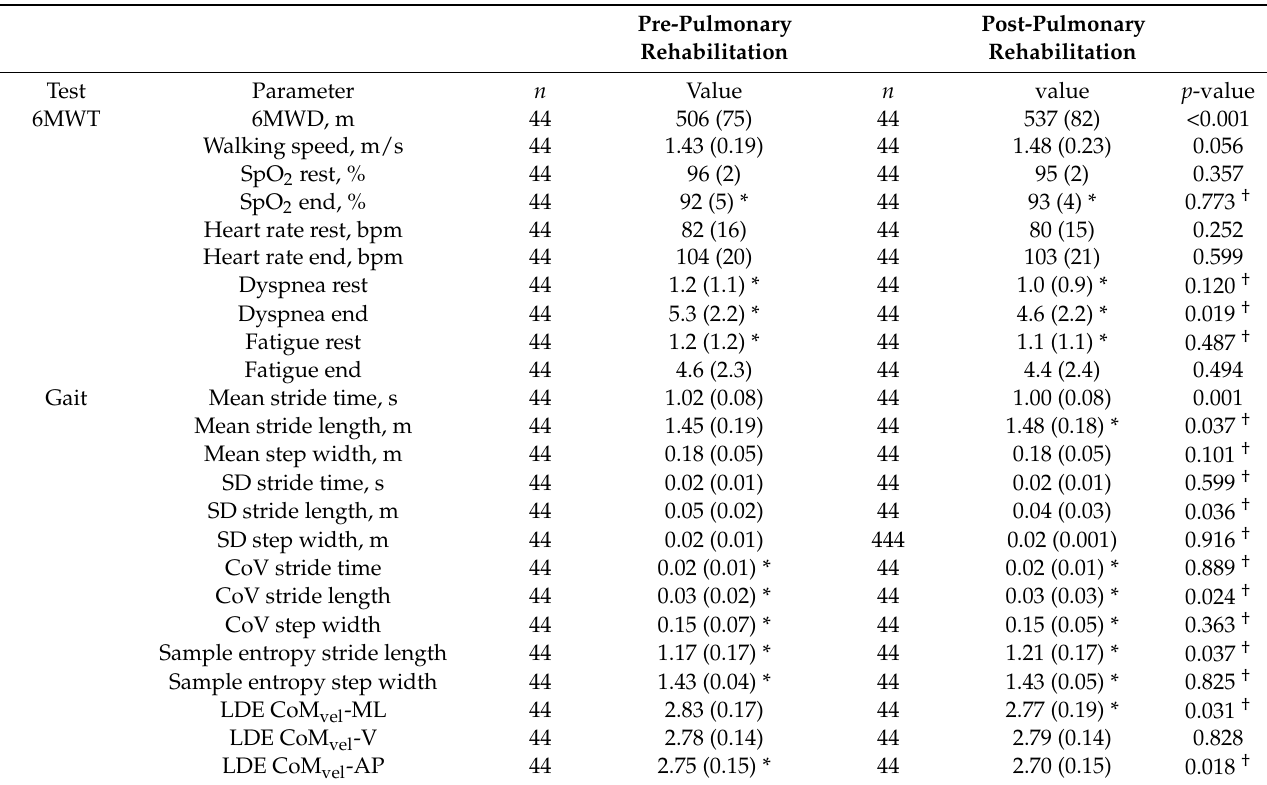
Table 3. The 6MWT outcomes and gait parameters during the GRAIL-based 6MWT before and after pulmonary rehabilitation.